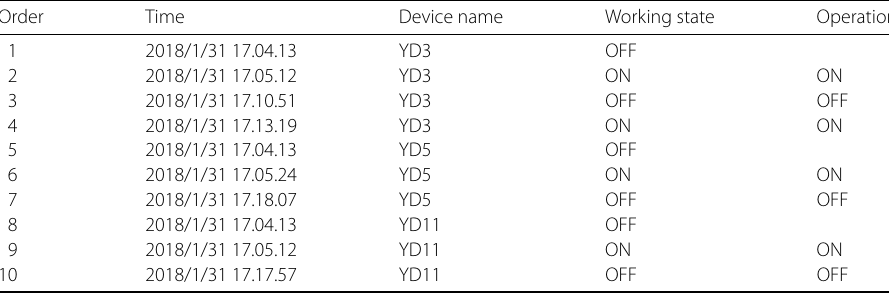
Table 6 Operation records of equipment group 5 Order